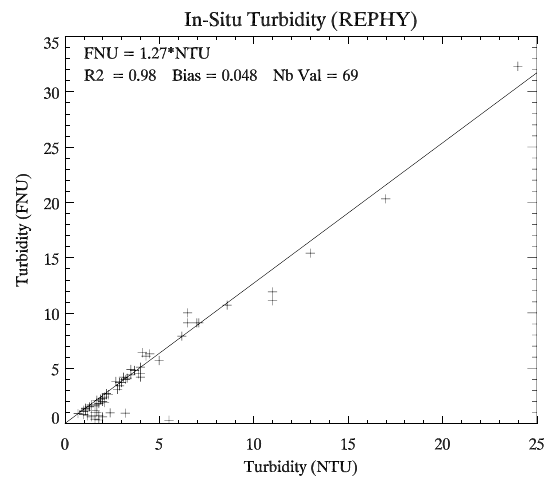
Fig. 9. Turbidity in FNU versus turbidity in NTU.